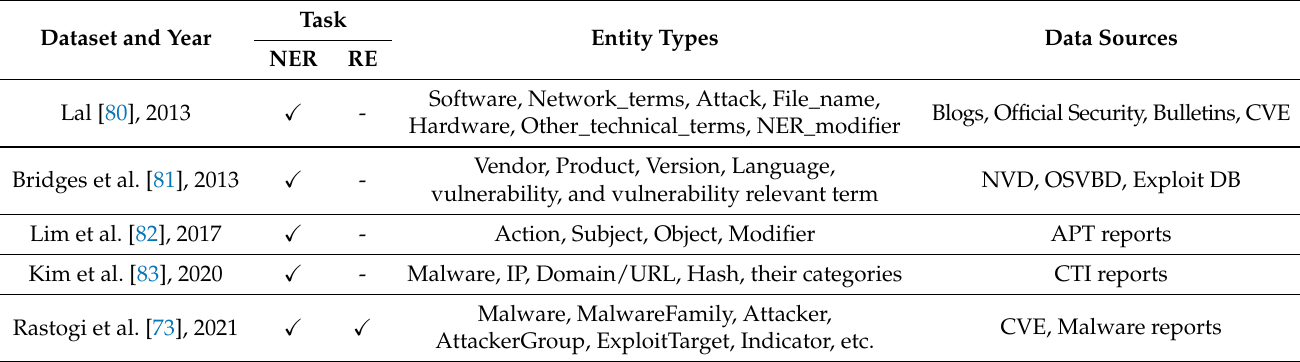
Table 2. The open datasets of information extraction task for cyber